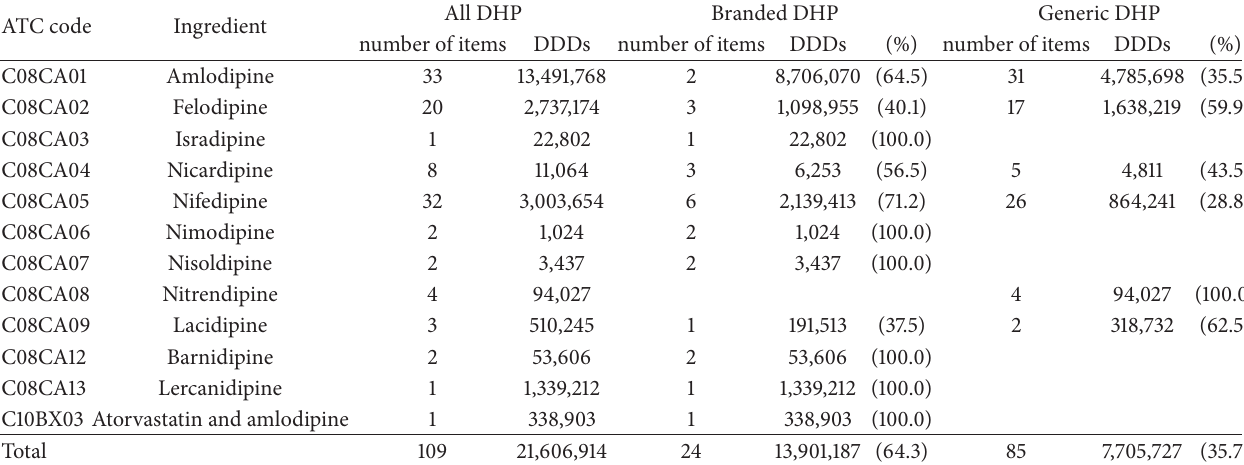
Table 1: Prescribing amount of DHP derivatives in one million beneficiaries within Taiwan’s National Health Insurance in 2010, stratified by ingredient and branded/generic